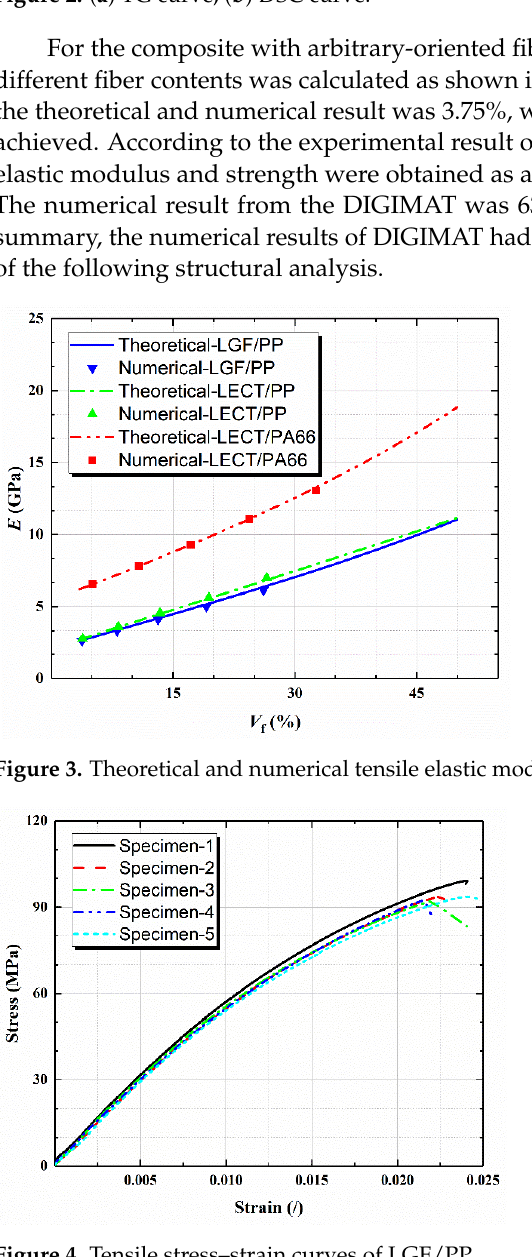
Figure 4. Tensile stress–strain curves of